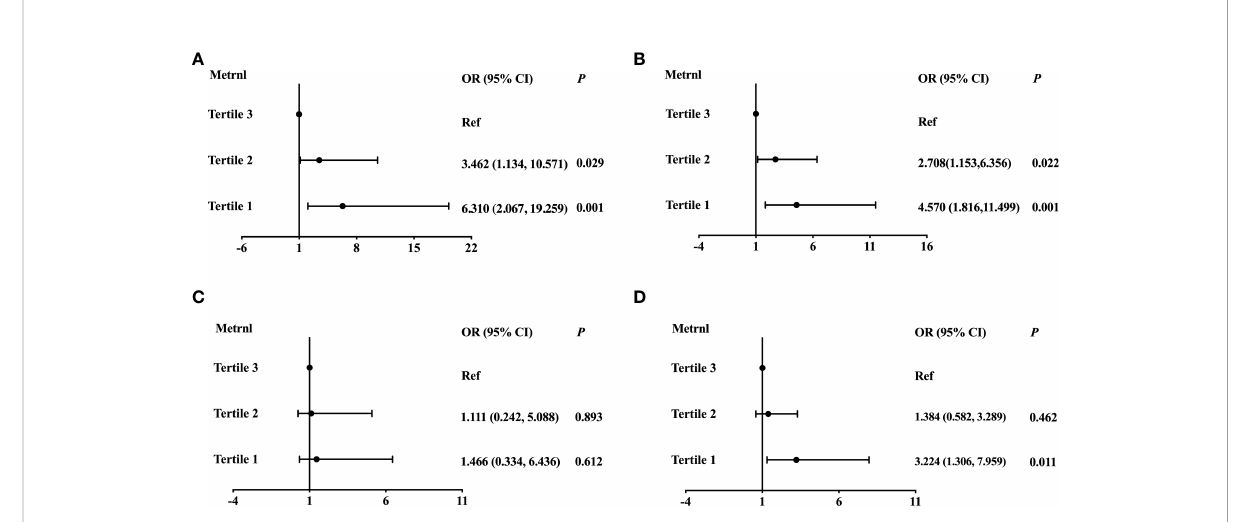
FIGURE 2 Logistic regression analysis of the association between serum Mternl levels with Hyper-TG (A) , Hyper-TC (B) , Hypo-HDL (C) , and Hyper-LDL (D) . Adjusted for age, sex, BMI, diabetes, HOMA-IR, and